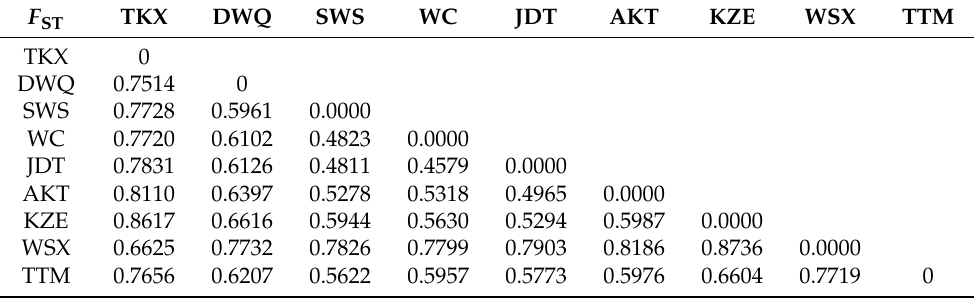
Table 3. Pairwise F ST among nine populations of T. yarkandensis